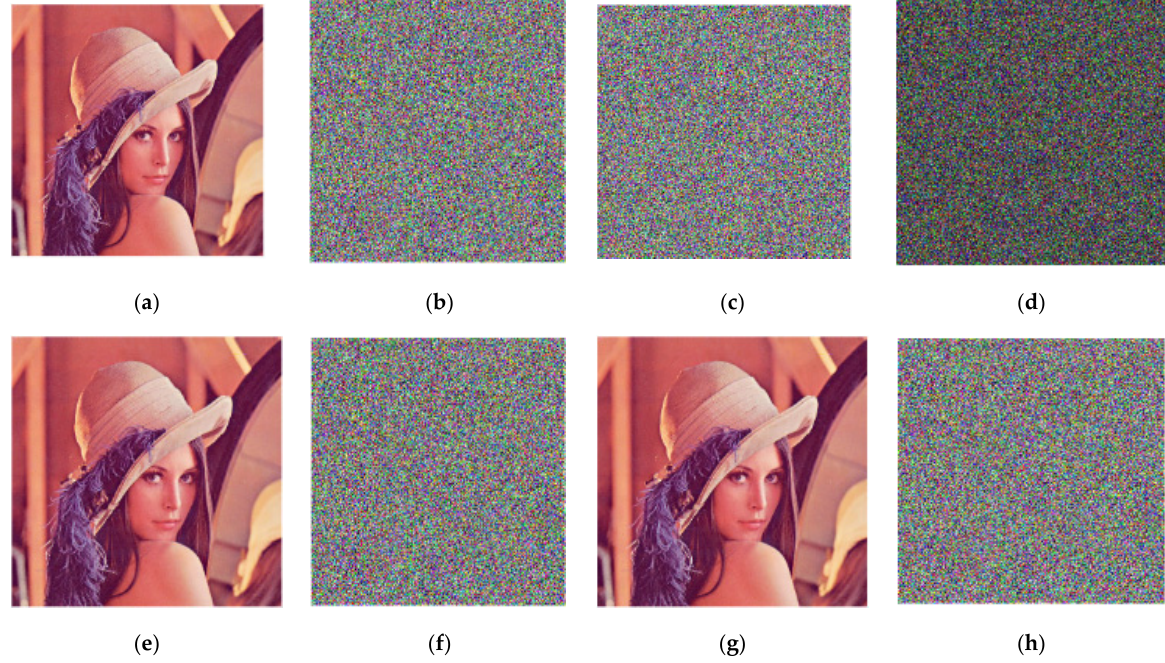
Figure 4. Key sensitivity: ( a ) Lena image; ( b ) Encrypted Lena with correct key; ( c ) Encrypted Lena with wrong key. ( d ) The difference between ( b ) and ( c ); ( e ) Decrypted Lena with the correct key from ( b ). ( f ) Decrypted Lena with the wrong key from ( b ); ( g ) Decrypted Lena with the key from( c ); ( h ) Decrypted Lena with the wrong key from( c ).